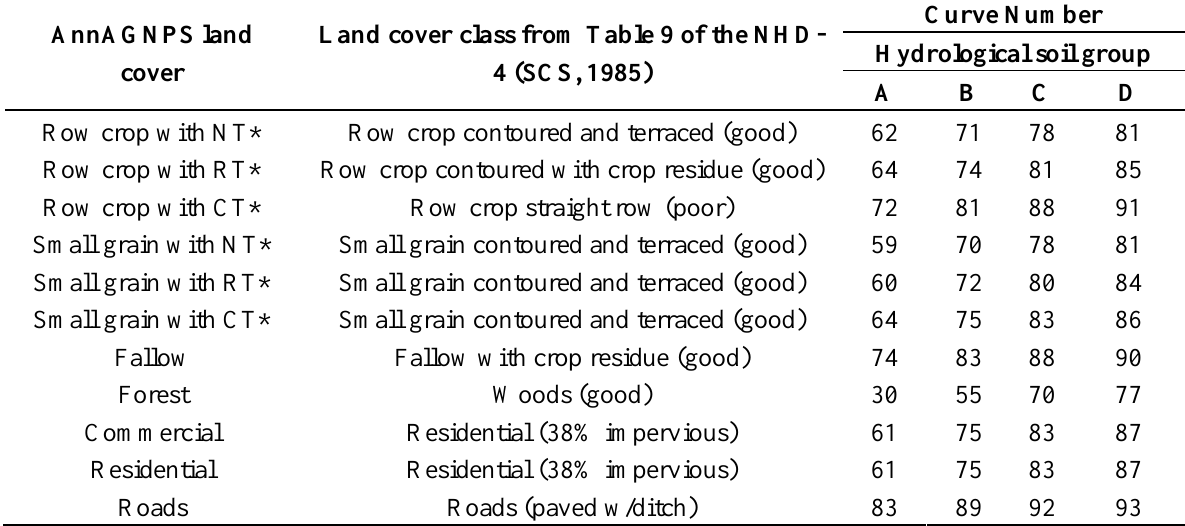
Table 5. Curve numbers used for model simulations after